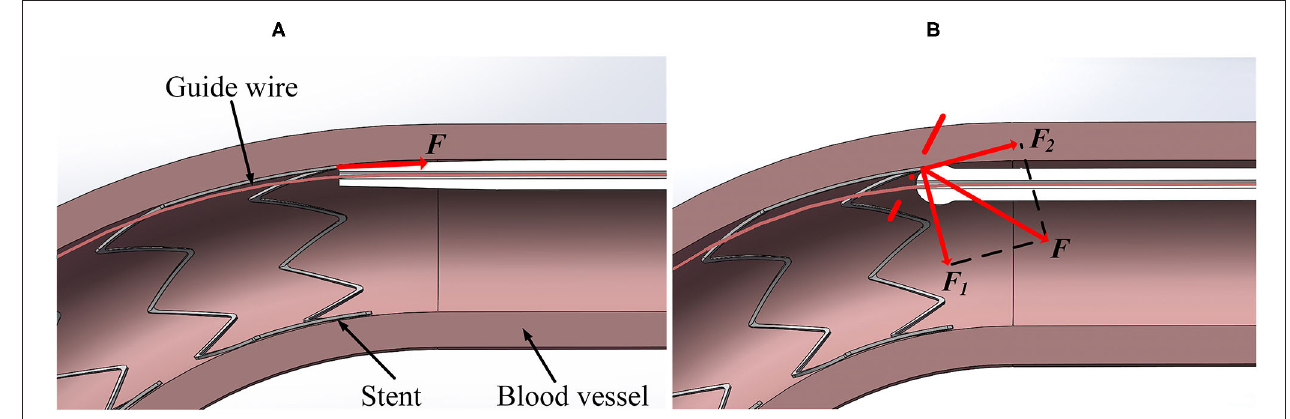
FIGURE 13 | Contact force analysis in different models from section view. (A) Traditional catheter model, and (B) spherical-tip catheter